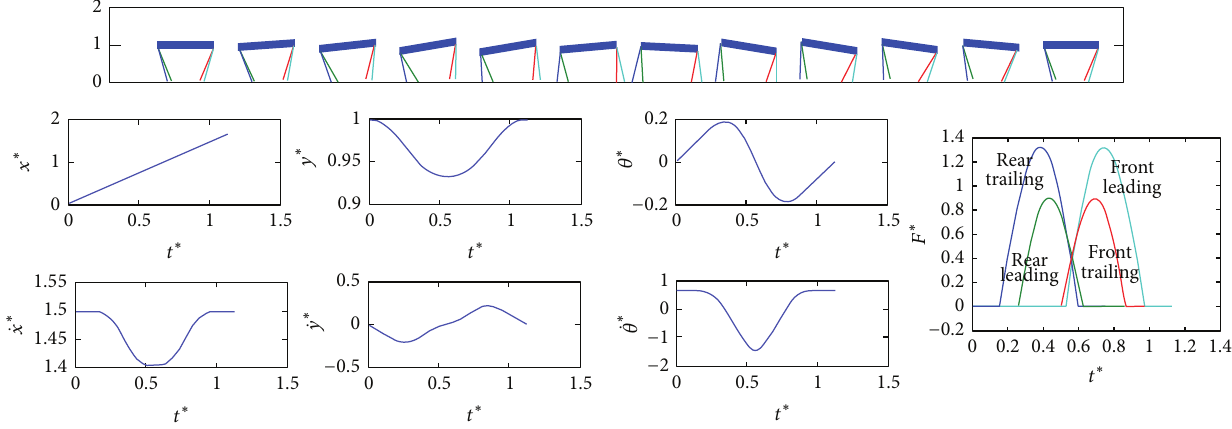
Figure 3: Snapshots and evolutions of states in transverse gallop. Initial conditions: 𝑦 ∗ 𝑠 = 1 , 𝜇 = 0.05 , 𝑝 = 1.0 , 𝑘 𝑎 = 1.0 , and V ∗ = 1.5 .